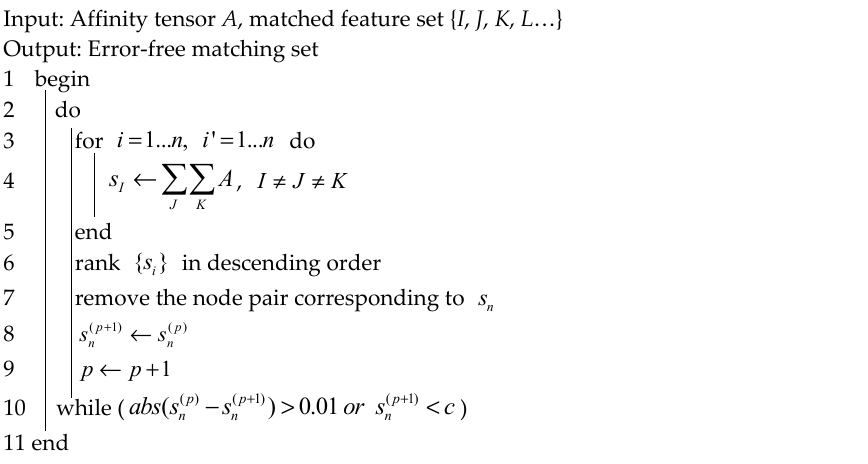
Algorithm 2: Blunder detection by the affinity tensor.